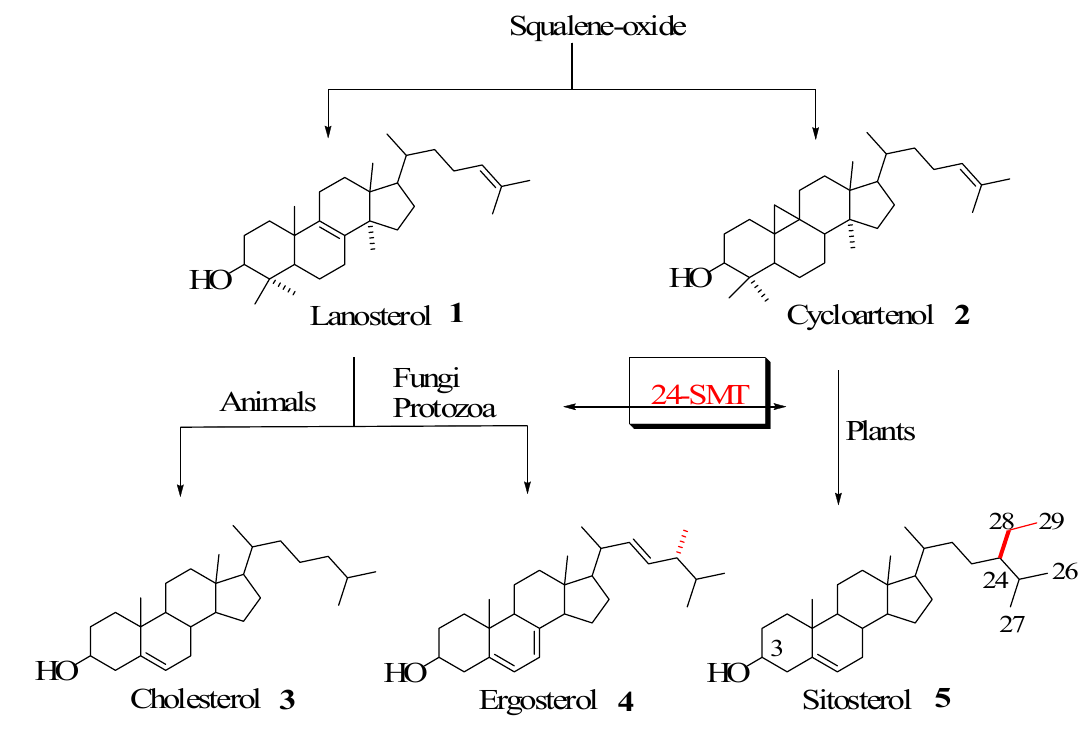
Figure 1. Biosynthesis of cholesterol and